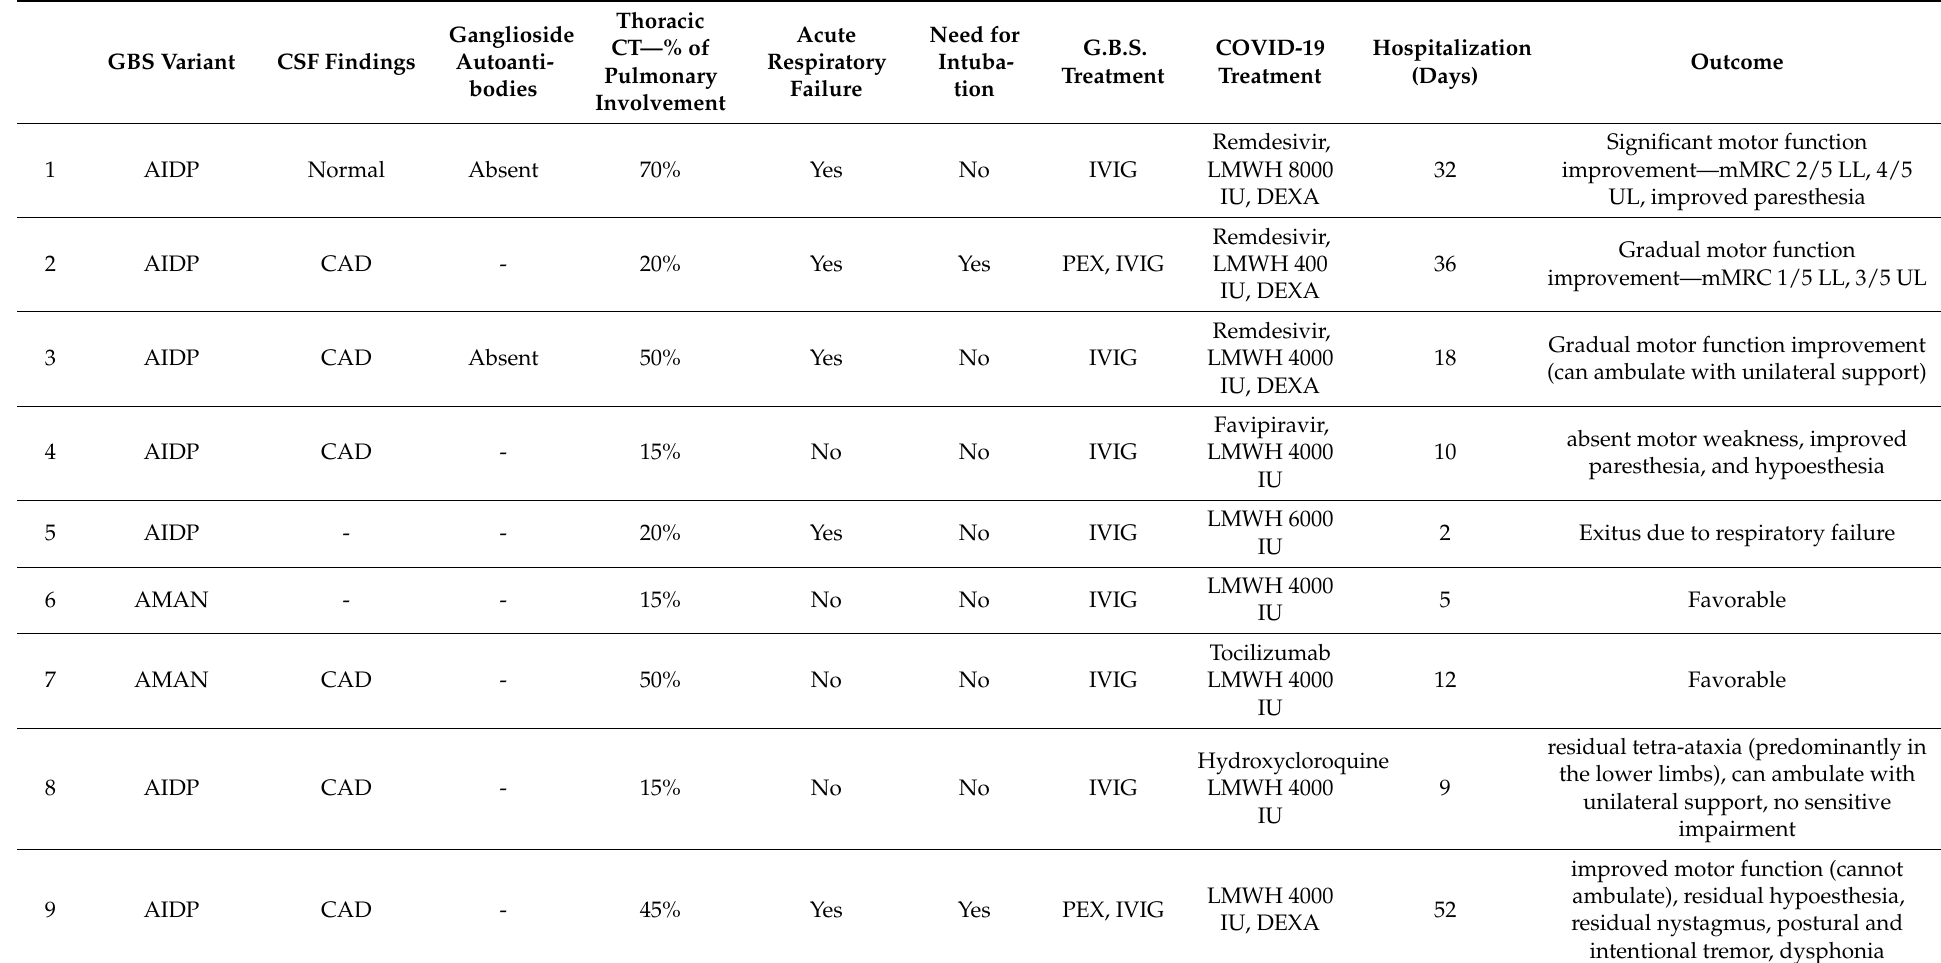
Table 3. Diagnosis, treatment,